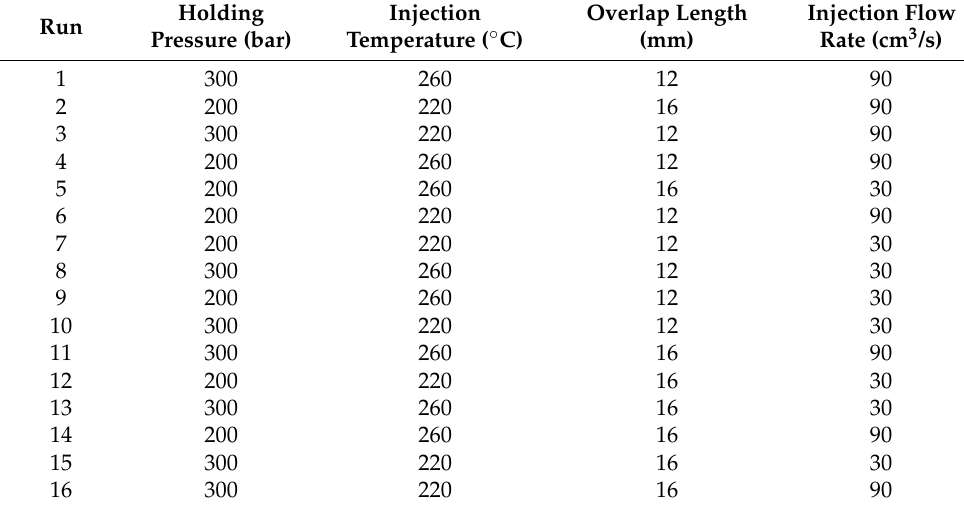
Table 2. Factor levels for the design of the polypropylene (PP)/composite factorial experiment.